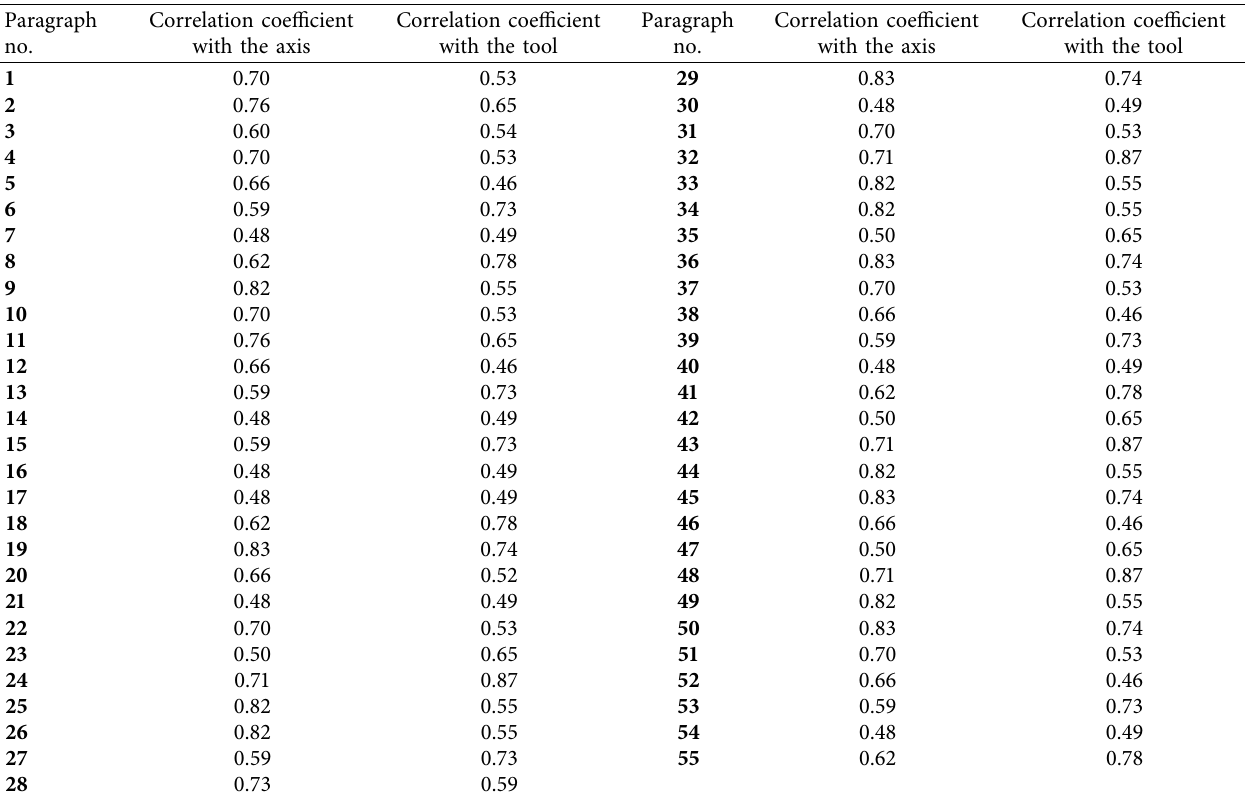
Table 2: The correlation coefficient values between the paragraphs of the tool and the dimension to which it belongs and its overall mark. Paragraph Correlation coefficient Correlation coefficient Paragraph Correlation coefficient Correlation coefficient no. with the axis with the tool no. with the axis with the tool 0.53 0.70